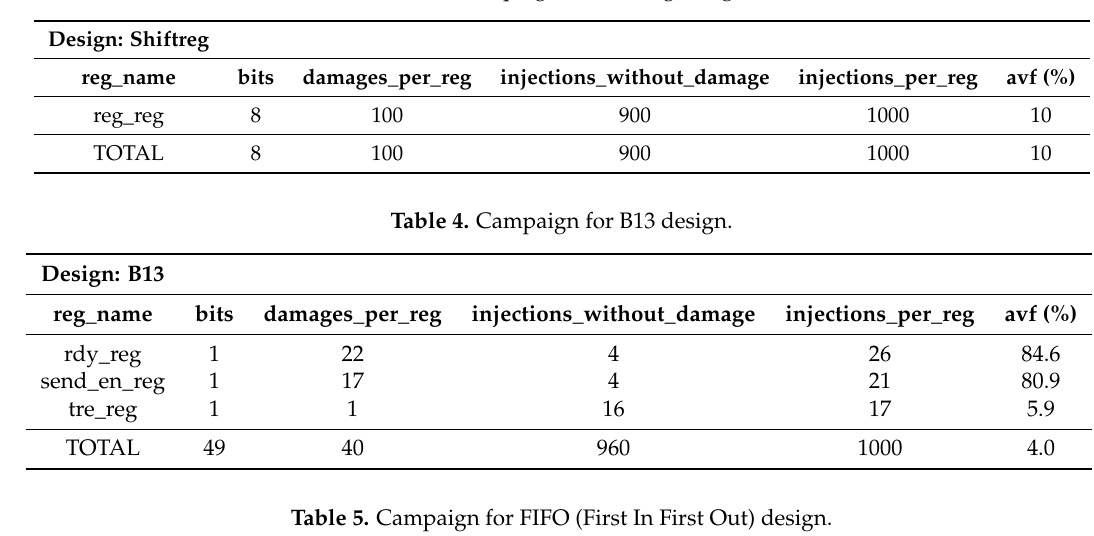
Table 3. Campaign for shiftreg design.